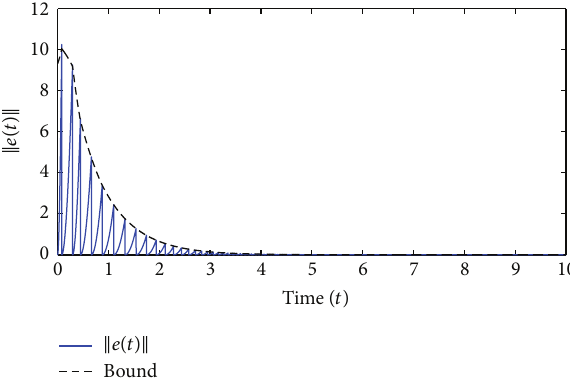
Figure 7: The evolution of position states 𝑥 𝑖 (𝑡) for 𝑖 = 0, 1, .. ., 4 .